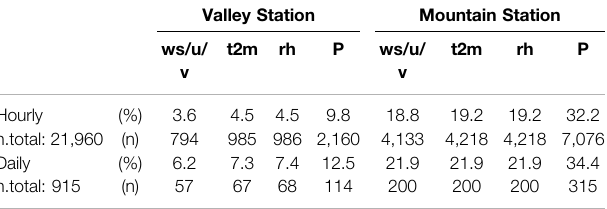
TABLE 1 | Percentage and total number (n.total) of missing values of the Valley and Mountain Station for daily and hourly values during the rainy season encompassing all variables considered in the evaluation of the AWS data.